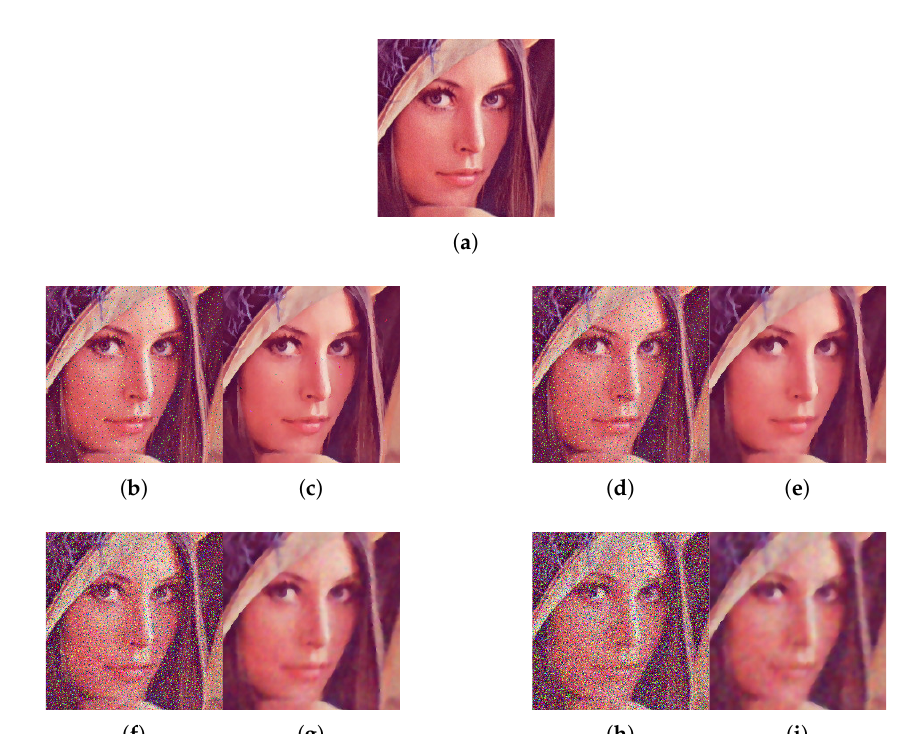
Figure 6. Method outputs. Lena image contaminated with impulse p and Gaussian noise σ . ( a ) Lena. ( b ) Noisy p = 0.05, σ = 5. ( c ) Filter output. ( d ) Noisy p = 0.1, σ = 10. ( e ) Filter output. ( f ) Noisy p = 0.2, σ = 20. ( g ) Filter output. ( h ) Noisy p = 0.3, σ = 30. ( i ) Filter output.